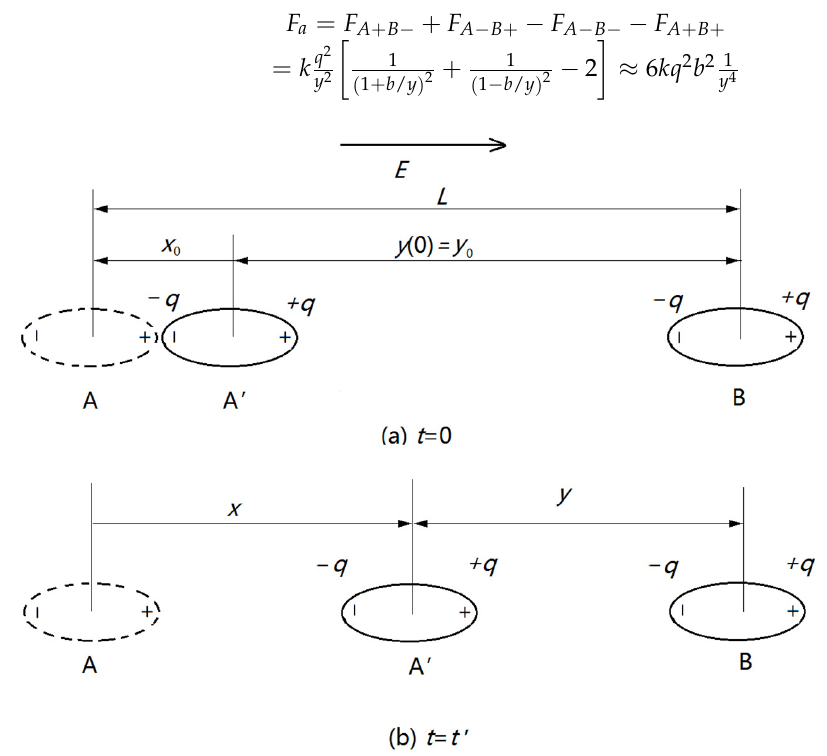
Figure 3. Kinetic model of a BNNS. ( a ) Initial state when t = 0; ( b ) mediate state when t = t (cid:48) . As to F r , if the velocity ( v ) of the BNNS is not high enough, F r is proportional to v , i.e.,: